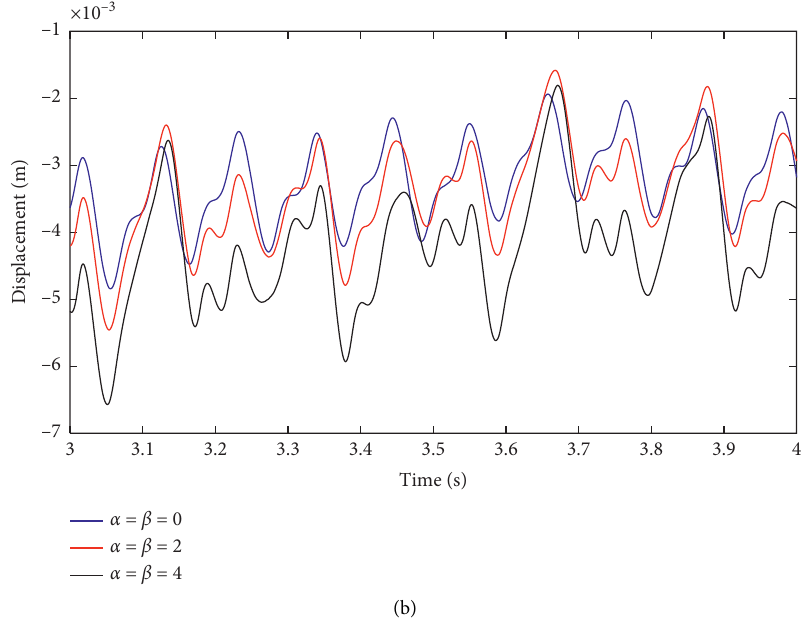
Figure 11: Controlled system behavior in the presence of system uncertainties. (a), (b). Detailed view of (a).